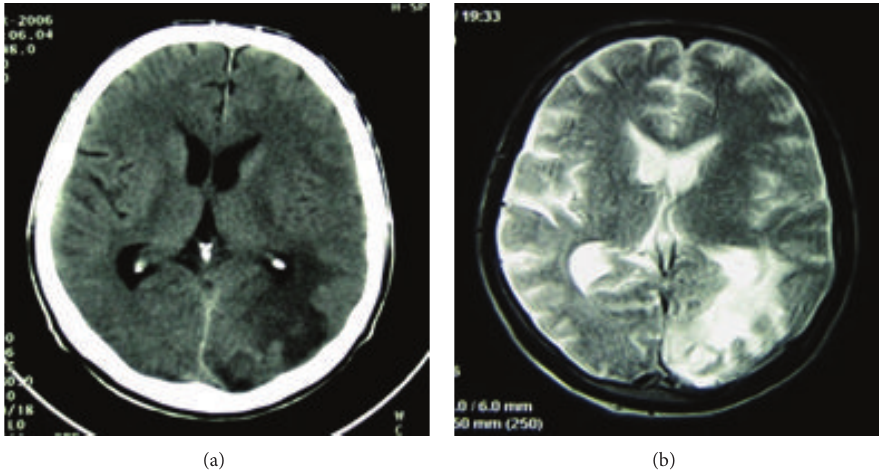
Figure 2: Metastatic changes in the left occipital region—a CT image (a) and an MR image